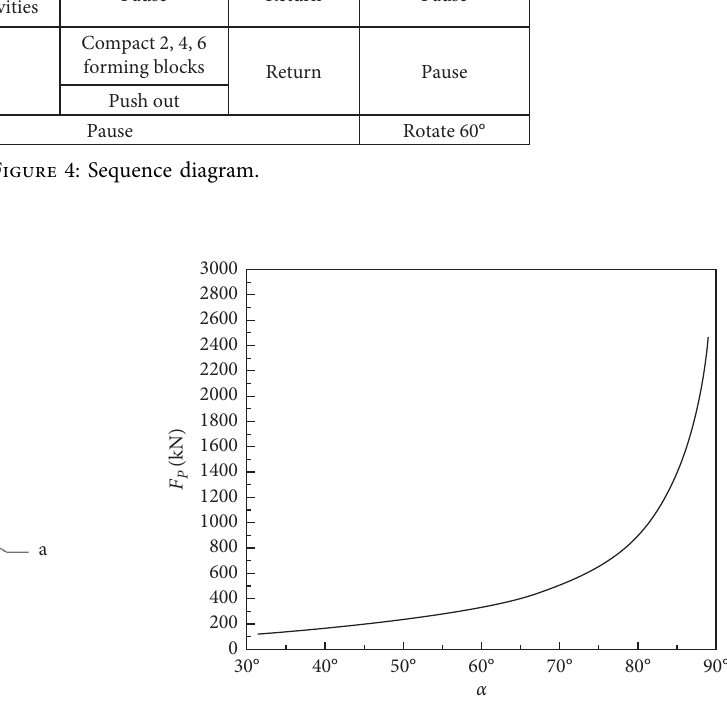
Figure 6: The relationship between the force of the hydraulic cylinder and the resistance of the material.